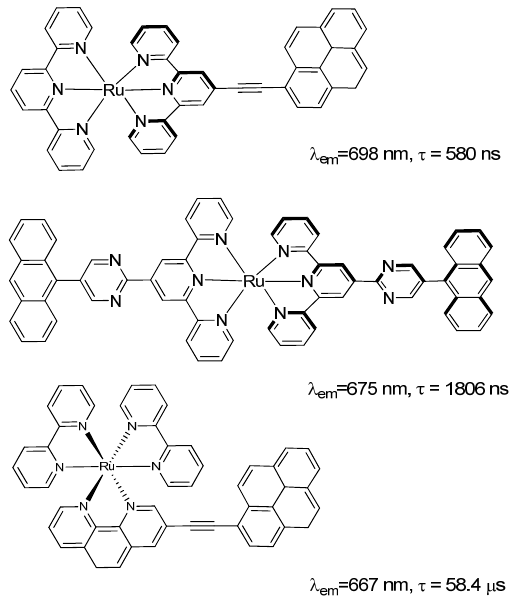
elongated lifetime of the activated state